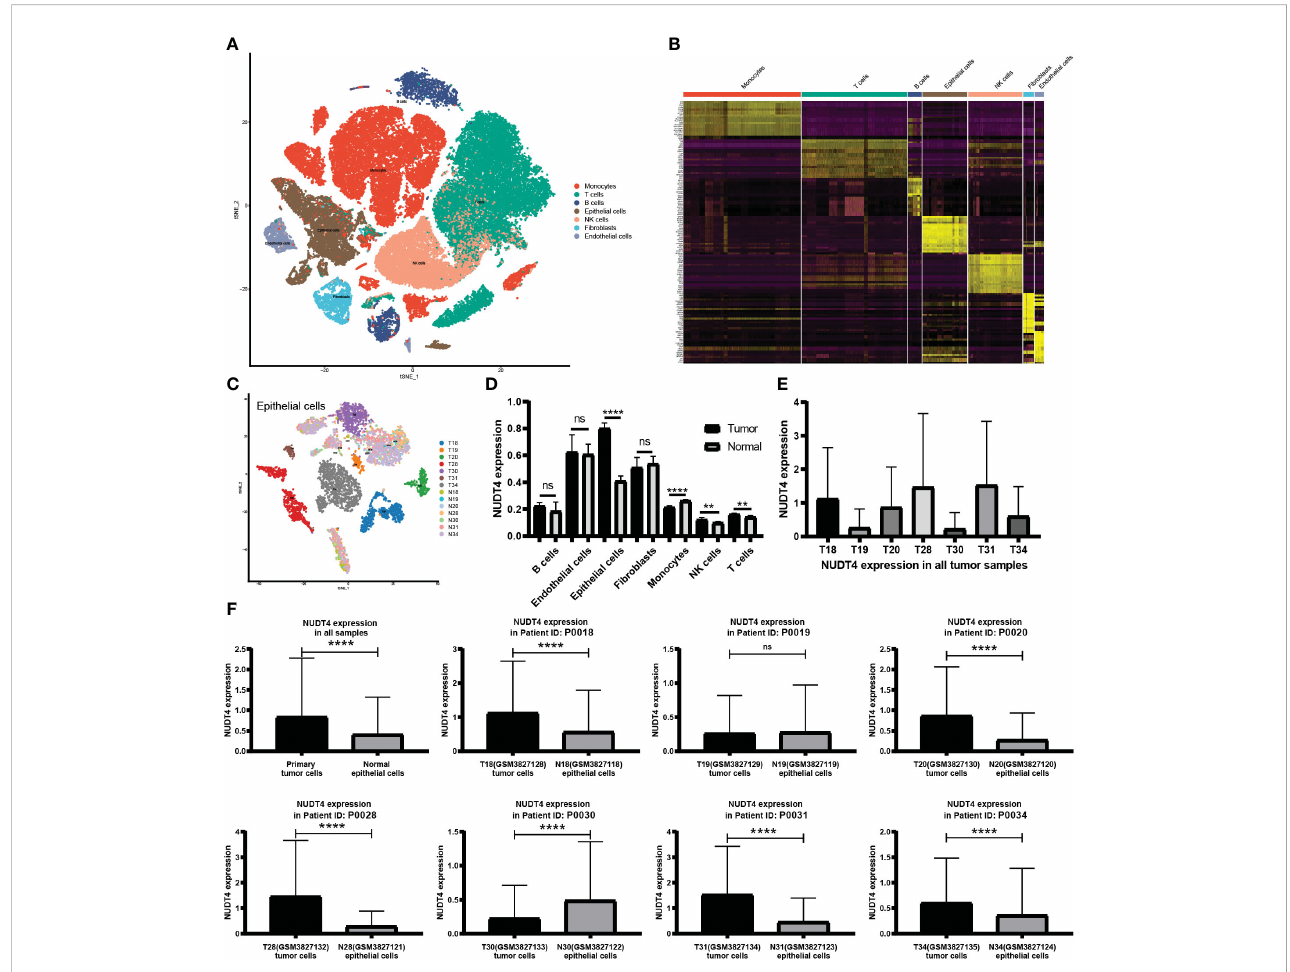
FIGURE 8 NUDT4 expression in single-cell RNA level. (A) Seven main cell types of tumor and normal samples were integrated in one Seurat project and visualized in t-SNE plot. (B) The top 10 marker genes of seven cell types. (C) Only epithelial cells were selected for NUDT4 analysis. (D) NUDT4 expression in different cell types. (E) NUDT4 expression in different samples. (F) NUDT4 expression in paired tumor and normal derived epithelial cells. (**P< 0.01, ****P < 0.0001, ns: Not statistically signi fi